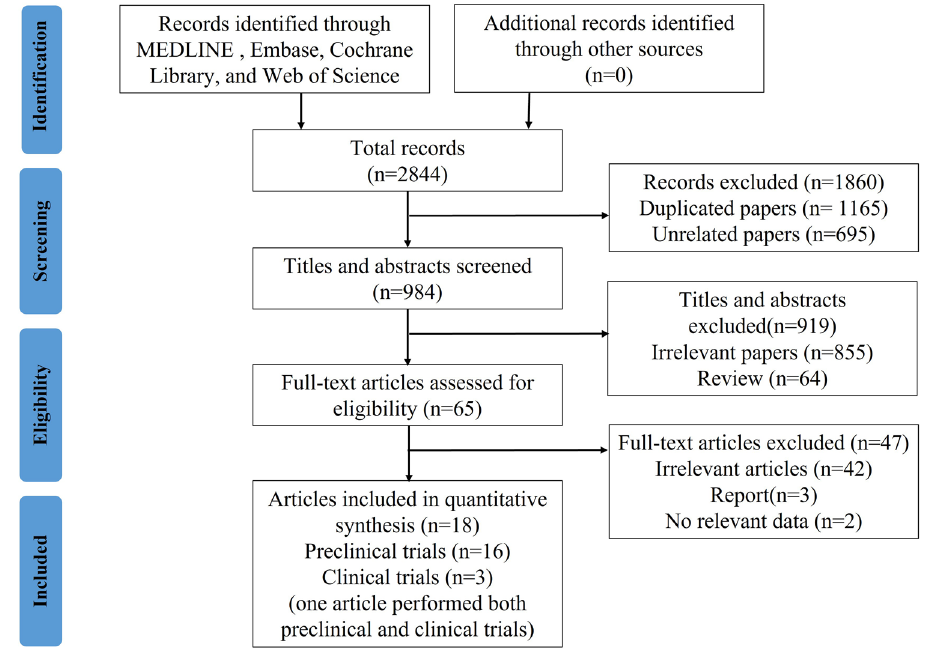
Figure 1. Flow chart of study